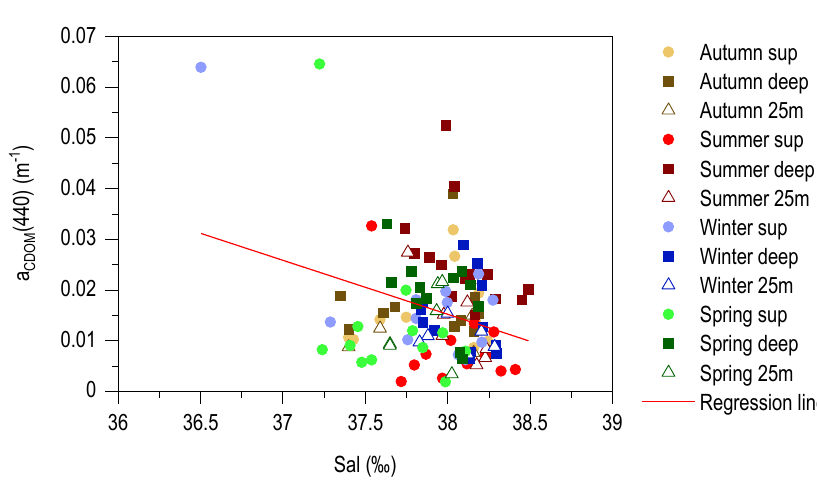
Figure 9. Relationship between S (nm − 1 ) and a CDOM (440) (m − 1 ).